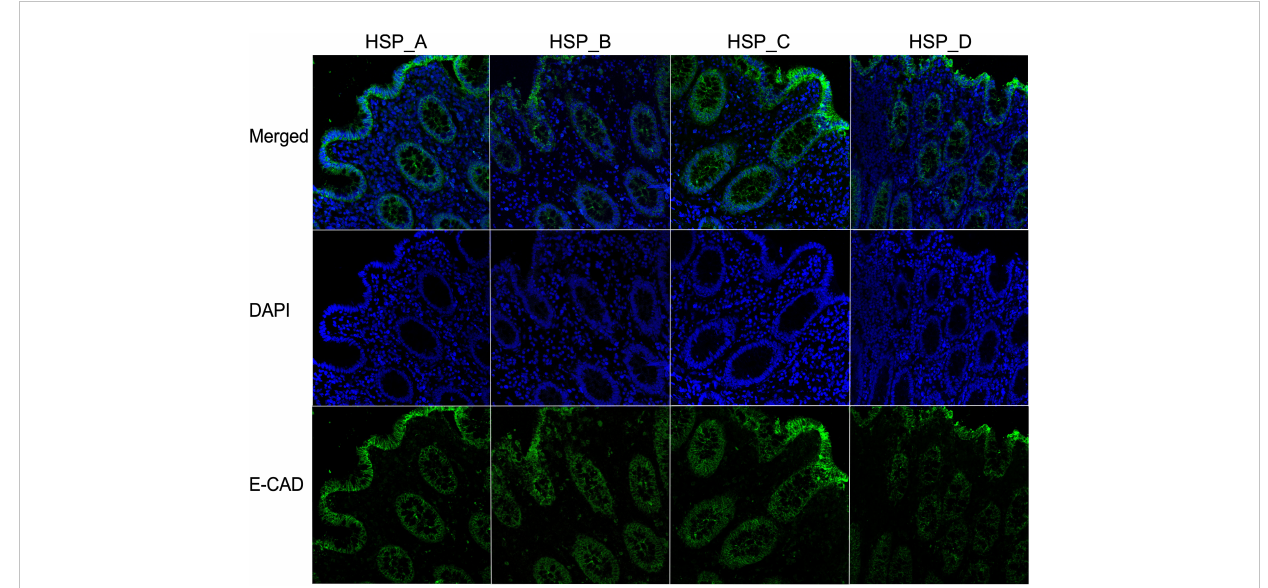
FIGURE 4 HSP from fertile donors does not affect the integrity of the colonic epithelial barrier. Representative images of the expression of E-CAD of three different colonic mucosa stimulated with HSP from four fertile donors (subject A – D ) for 90 minutes. The E-CAD mAb was followed by Alexa Fluor 488-conjugated goat anti-mouse IgG1 antibody (green). DAPI stained the nuclei (blue). 40X magni fi